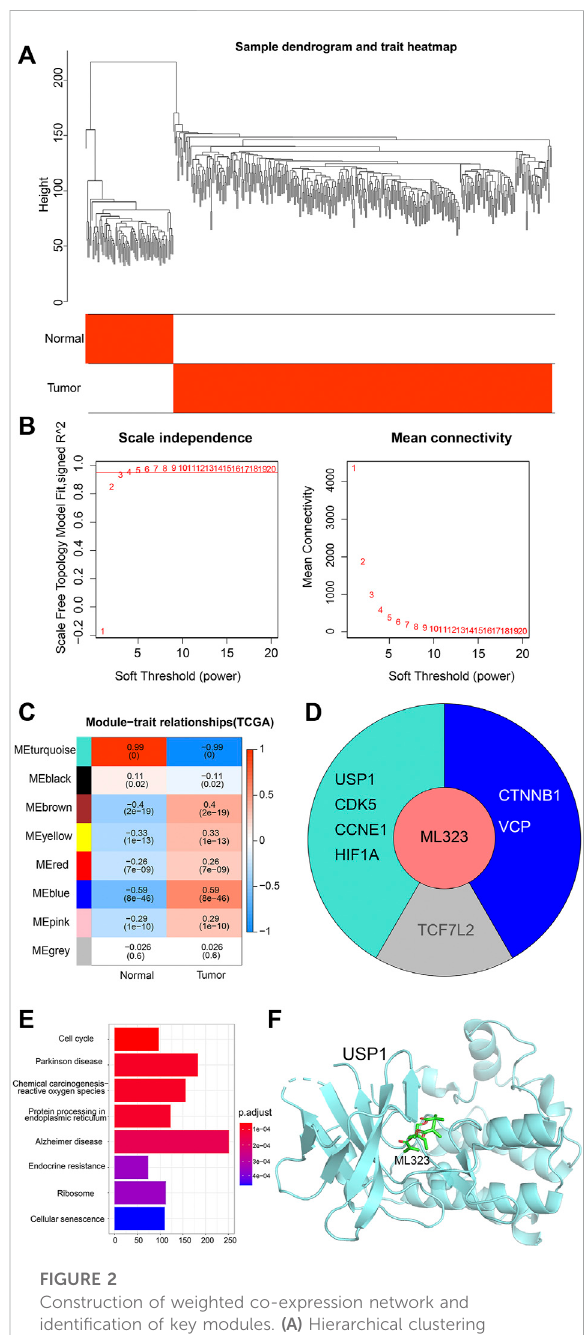
FIGURE 2 Construction of weighted co-expression network and identi fi cation of key modules. (A) Hierarchical clustering dendrogramofOVsamplesandnormalovarysamples. (B) Analysis of scale-free fi t metrics. (C) Correlation of modularity with normal group and OV group. (D) Modules distributed by the 8 target genes of ML323. (E) Pathway analysis of the turquoise module in which the four target genes of ML323 are located. (F) Molecular docking simulation of ML323 and